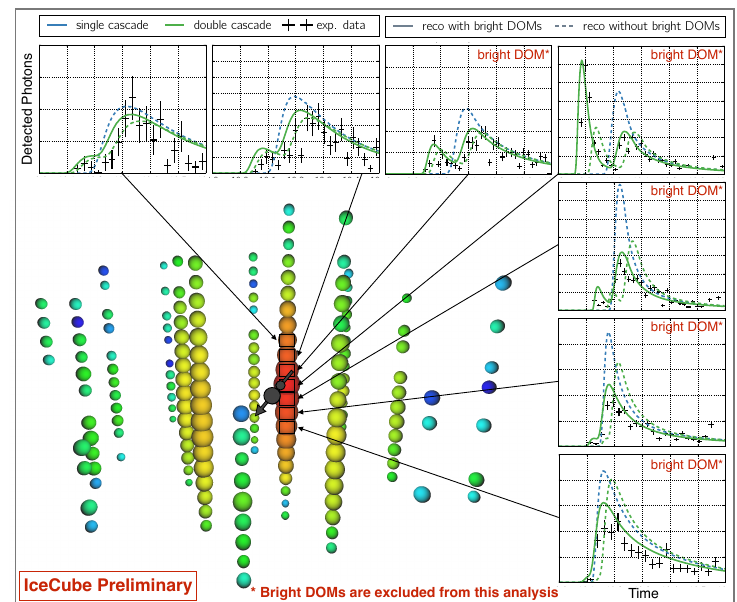
Figure 4: Double cascade event display. The colored circles indicate optical modules, where the color scale runs from red (earliest photon arrival time) to green (later photon arrival time). The size of the circle indicates the amount of deposited charge in the optical module. The reconstructed (double) cascade positions are indicated by grey circles and the direction is indicated by a grey arrow. The sizes of the grey circles illustrate the relative deposited energy in the two cascades. The surrounding plots are time distributions of detected photons in selected optical modules in the